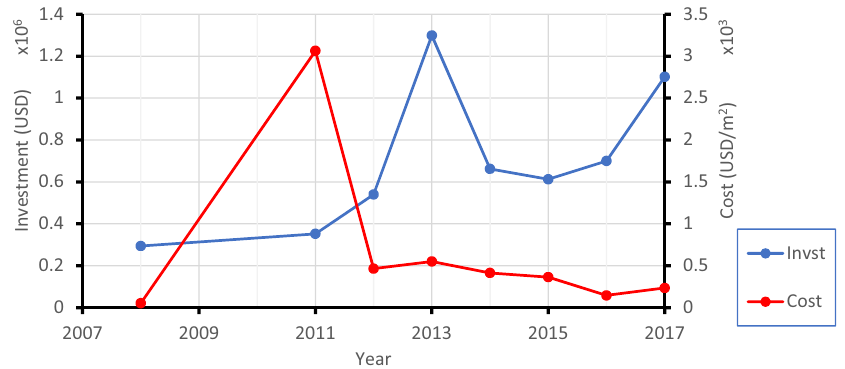
Figure 25: Economic every - year evolution of SHIP plants.